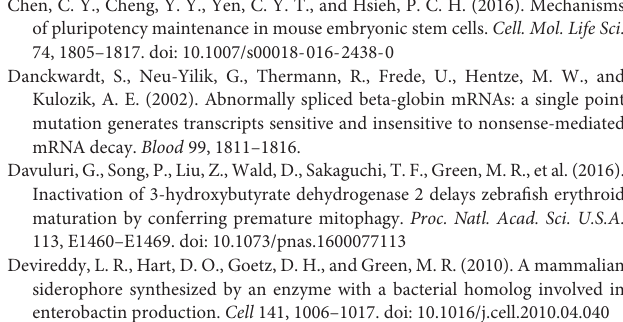
Supplementary Figure 1 | Identification of bi-allelic Bdh2 -knockout mouse embryonic stem cells (ESCs). (A) Expression of Bdh2 in different cell lines by